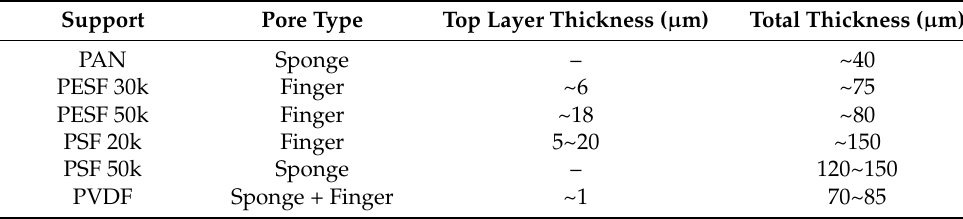
Table 1. The overall thickness of the 6 porous supports selected.